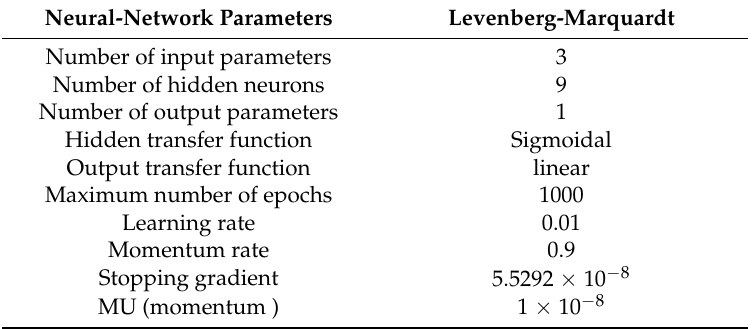
Table 1. Neural network-Levenberg-Marquardt algorithm (LMA) configuration